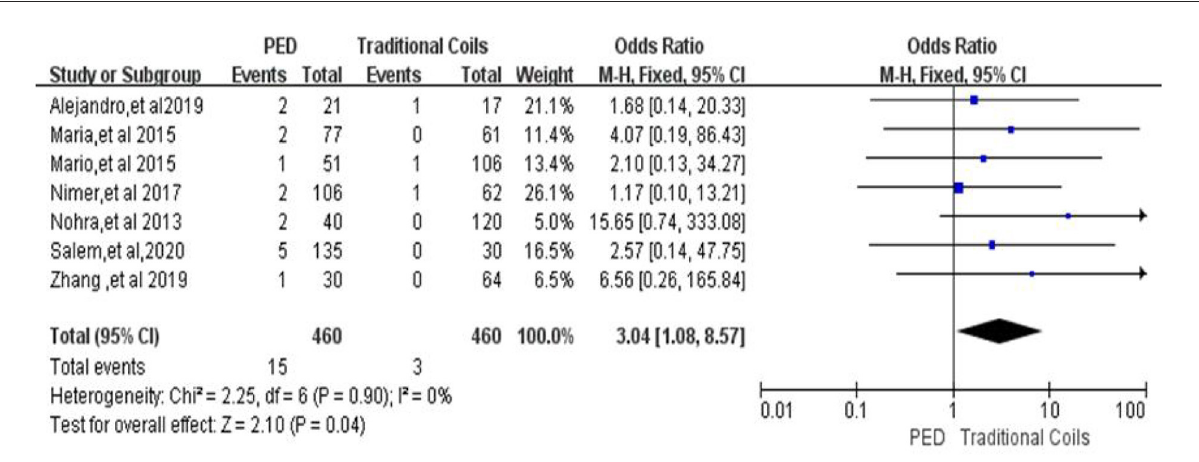
FIGURE2 Forest plot and meta-analysis of procedure-related intracranial hemorrhage.